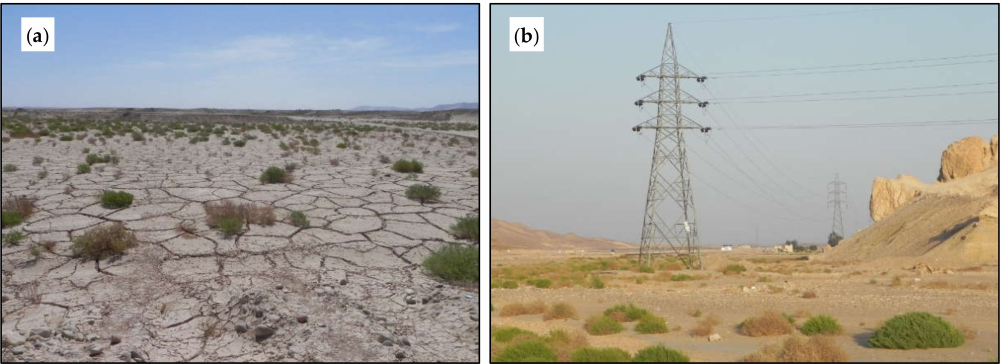
Figure 2. Wadi Qena. ( a ) Main channel showing the dry conditions and limited vegetation of the wadi and ( b ) electricity towers located in the main channel of the wadi (observed during a field trip in